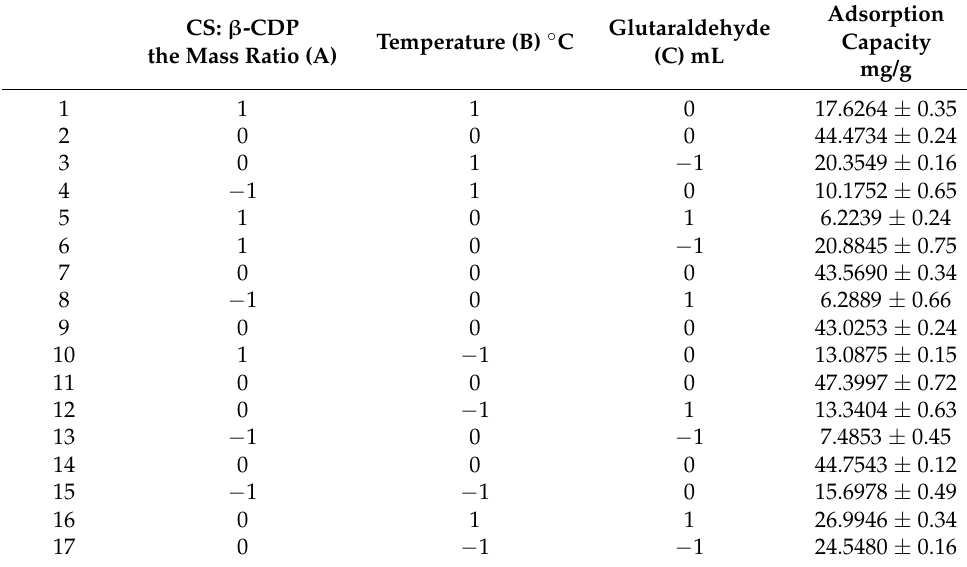
Table 2. The experimental results of the response surface.